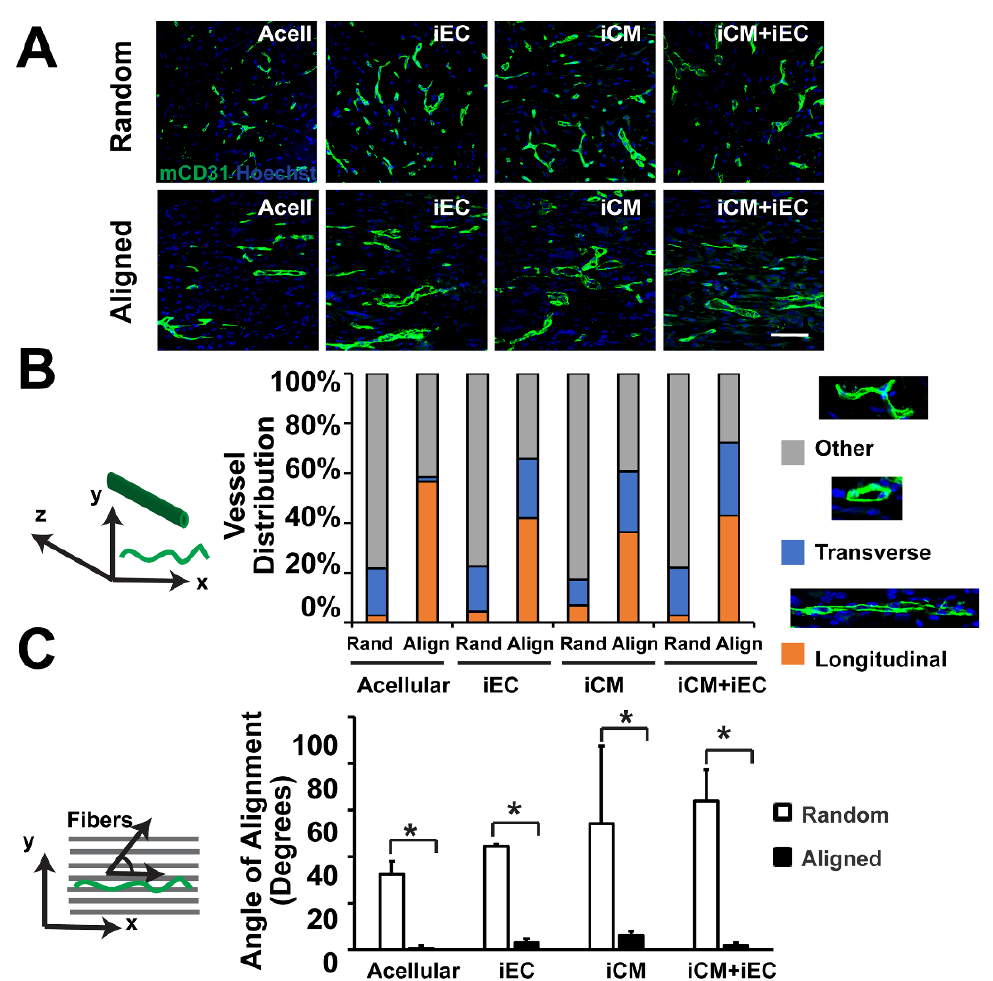
Figure 3. Vascularization of engineered myocardial tissue following subcutaneous implantation into mice. ( A ) Representative confocal microscopy images of CD31 staining (green) within en face sections of engineered myocardial tissues derived from randomly oriented or aligned nanofibrillar scaffolds containing iPSC-derived cardiomyocytes (iCMs), iPSC-derived endothelial cells (iECs), or iCM + iECs at 2 weeks after subcutaneous implantation. Acell denotes acellular scaffold. ( B ) Distribution of vessel orientations within explanted engineered myocardial tissue, relative to the axis of the aligned microfibers as longitudinal, transverse, or other. ( C ) Quantification of the global angle of vessel alignment within subcutaneously explanted engineered myocardial tissues, relative to the axis of the aligned microfibers. The global angle of vessel alignment is calculated as the angle formed by the direction of the longitudinally oriented vessel with respect to the axis of the aligned microfibers. For randomly oriented scaffolds, an arbitrary axis was selected ( n ≥ 3). Reprinted with permission from [127]. * Denotes statistically significant in comparison ( p < 0.05).